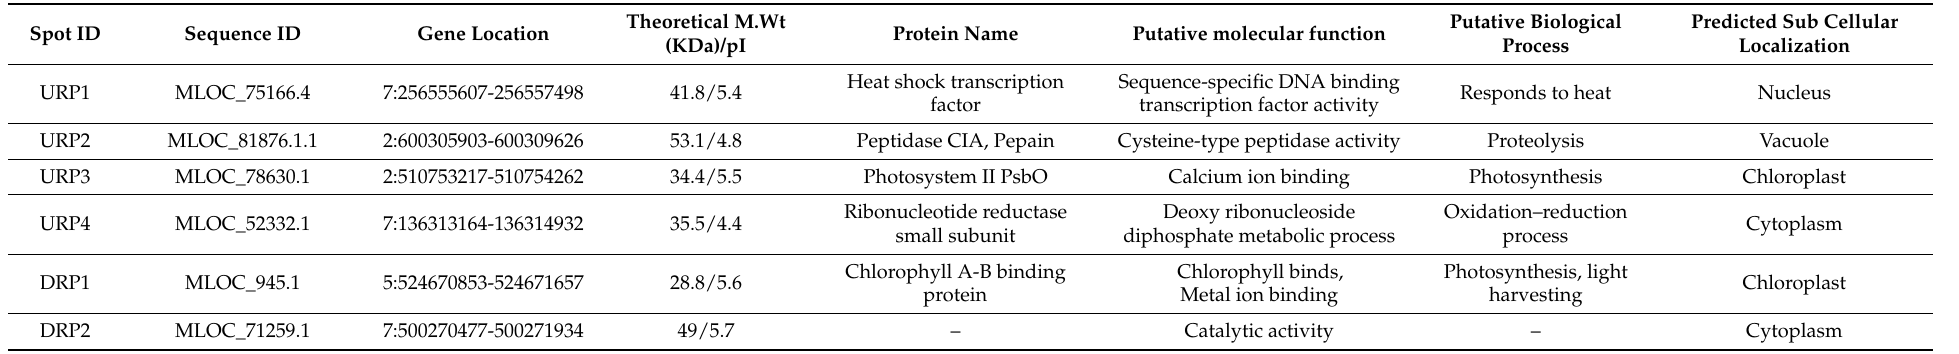
Table 3. List of proteins identified by MALDI-TOF-MS/MS analysis in barley cv. NDB-1445 in response to R. solani